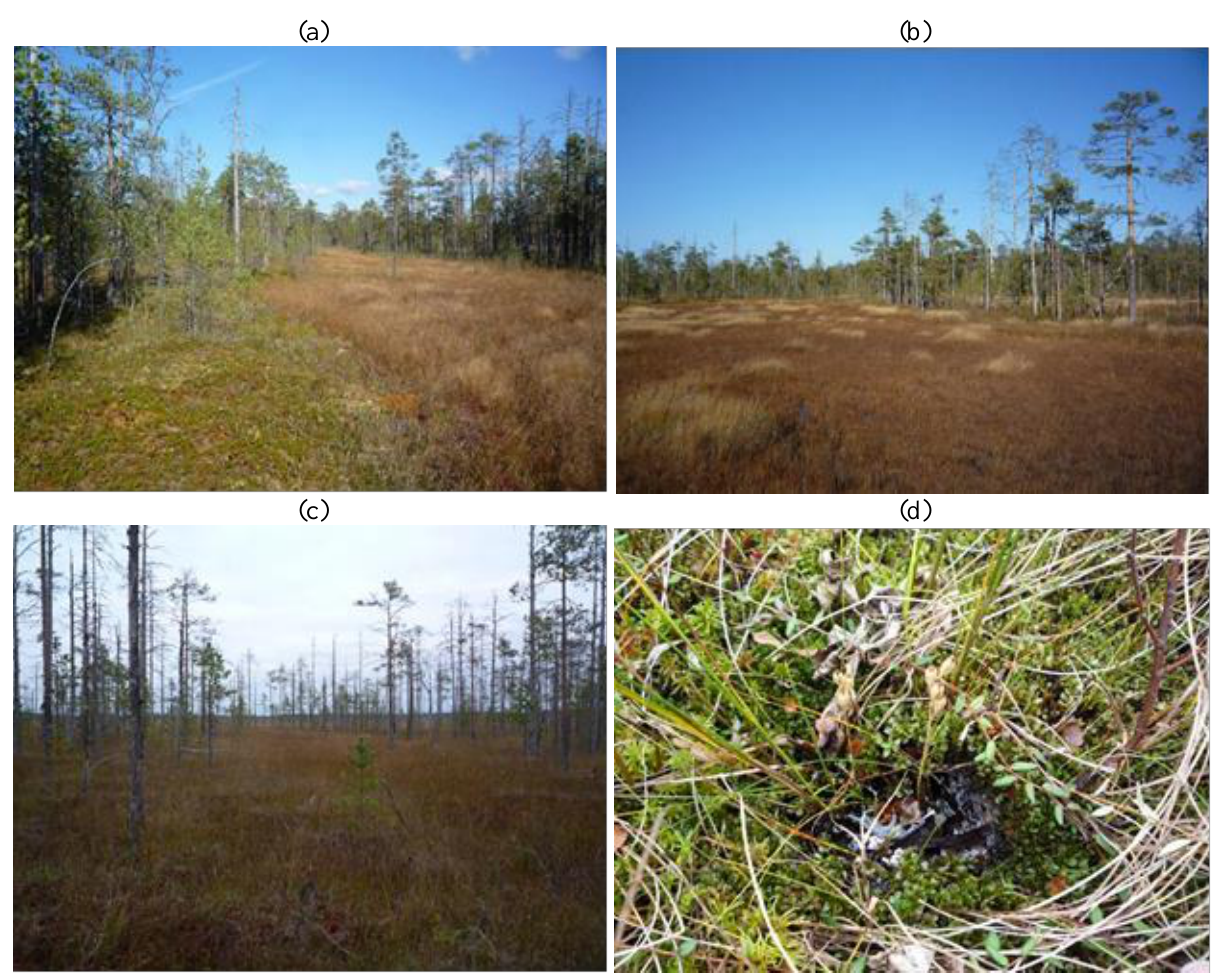
Figure 2. Piyavochnoe mire system: (a) string-flark microtopography (Sample Plot 2); (b) flark-dominated pattern (Sample Plot 4); (c) under-developed string-flark pattern (Sample Plot 5); (d) Liparis loeselii